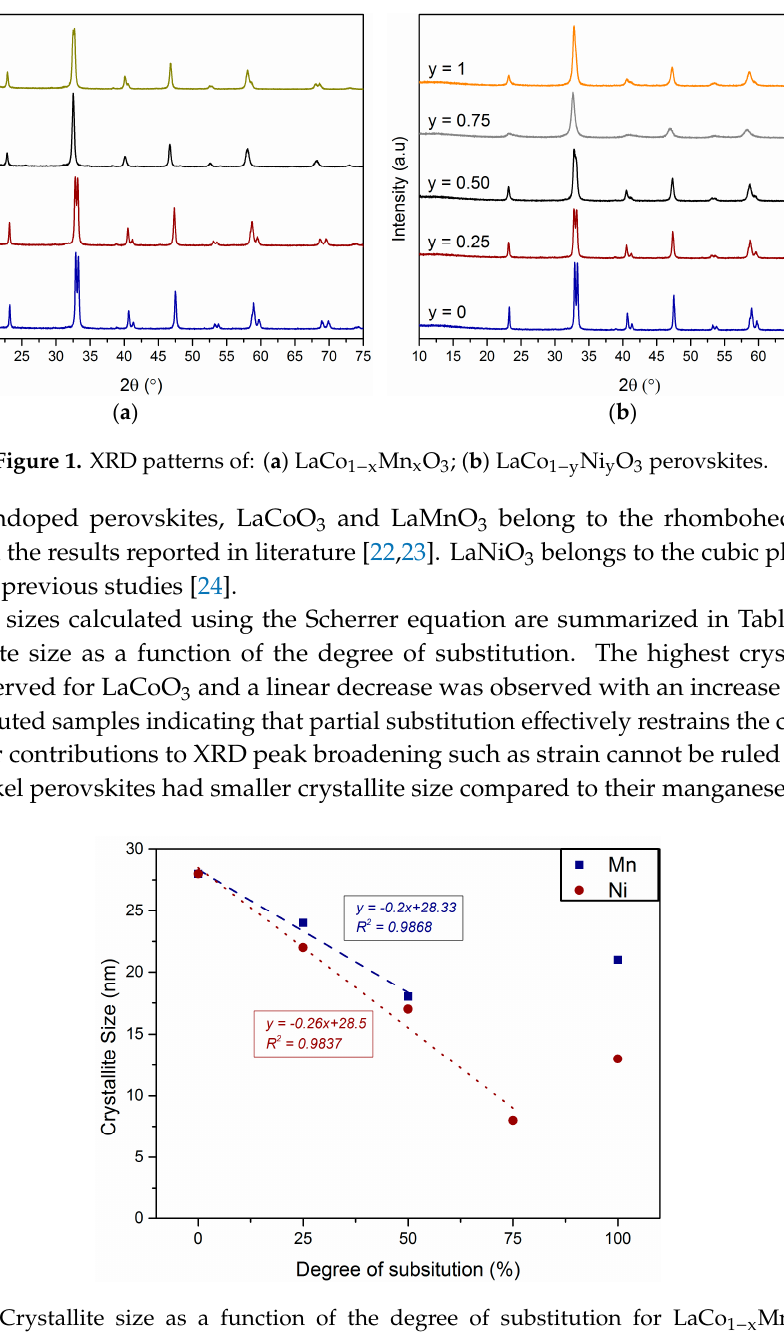
Figure 2. Crystallite size as a function of the degree of substitution for LaCo 1 – x Mn x O 3 and LaCo 1 – y Ni y O 3